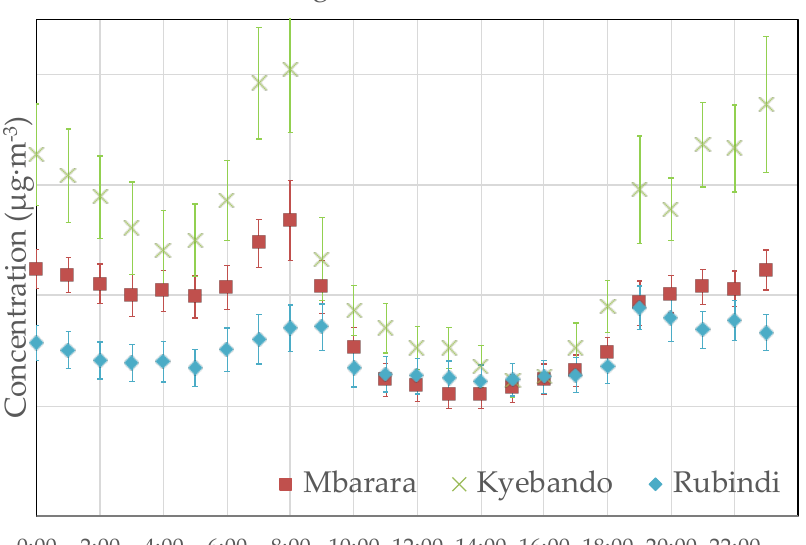
Figure 4. Diurnal variations in particulate matter concentration. These data were collected using the real-time instrument. Readings for each day were averaged by the hour, and the same hour was averaged over all sampling days to yield the plotted points ( N = 39, 25, 30 for Mbarara, Kyebando, and Rubindi). Error bars are the standard deviation of the mean for the same hour on all sampling days. See Table 3 for a comparison of gravimetric and real-time concentration measurements. Table 2. Comparison of daytime / overnight PM 10 levels ( µ g · m − 3 ) measured at three di ff erent locations using light-scattering techniques. N is the number of samples for which valid light-scattering data were collected at each location.